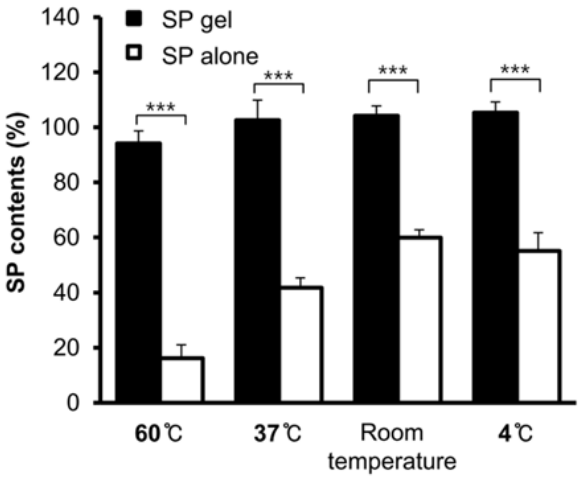
Figure 2. Analysis of SP gel stability at various temperatures. SP alone or SP gel was stored at 60 °C, 37 °C, room temperature, and 4 °C for 4 weeks. A sample at 0 weeks without incubation at different temperatures served as a control. The stability of SP alone and SP gel was analyzed by ELISA. Values represent mean ± SD of three independent experiments. *** p < 0.001.